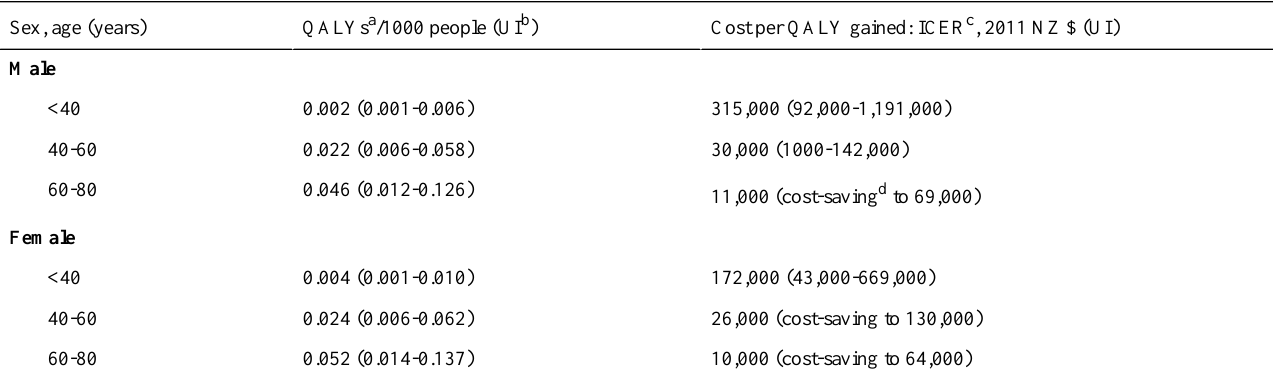
Table 3. Results for M ā ori (Indigenous population) with equity adjustment applied (lifetime gains, 3% discount rate).